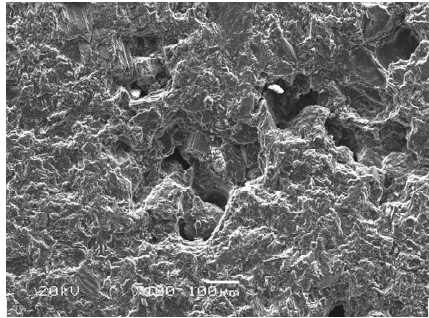
Figure 10. SEM morphology of the original surface.